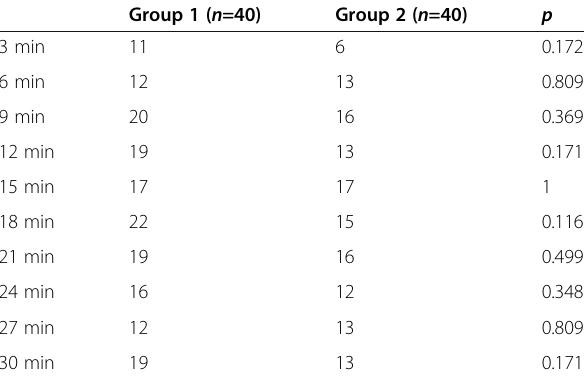
Table 4 The number of patients who experienced hypotension in each time